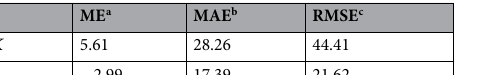
ME a MAE b RMSE c